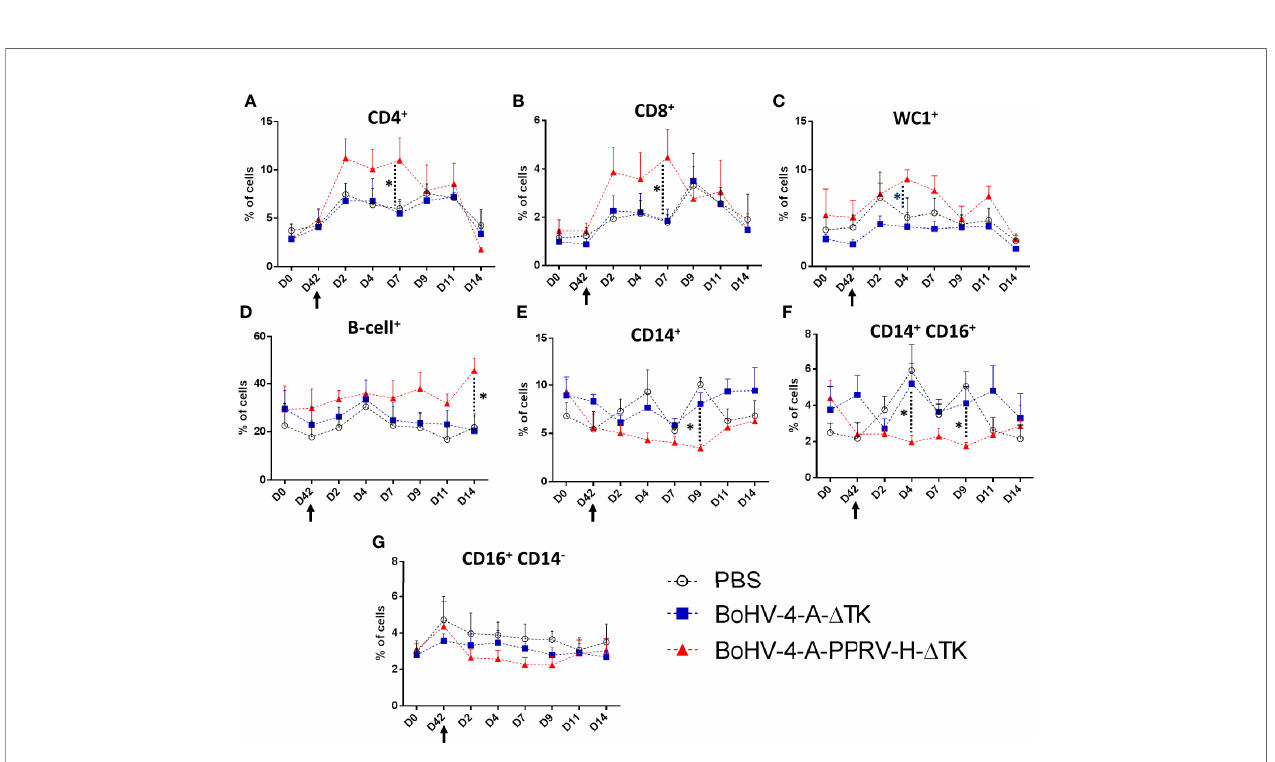
FIGURE 8 | Effect of BoHV-4-A-PPRV-H- D TK vaccination in ovine PBMC populations. PBMCs obtained from the three treatment groups [PBS (black), BoHV-4-A- D TK (blue), and BoHV-4-A-PPRV-H- D TK (red)] were stained with different monoclonal antibodies and analyzed by fl ow cytometry at different time points [pre- immunization (D0), pre-challenge (D42), and days 2, 4, 7, 9, 11, and 14 post-challenge (PC)]. Average percentage of (A) CD4 + cell population, (B) CD8 + cell population, (C) WC1 + ( gd T cell) population, (D) B-cell + population, (E) CD14 + cell population, (F) CD14 + CD16 + cell population, and (G) CD16 + CD14 − cell population for each sheep group were plotted. * p < 0.05 one-way ANOVA test (BoHV-4-A-PPRV-H- D TK vs . BoHV-4-A- D TK and PBS control groups). The black arrow (D42) denotes the time of virulent PPRV ICV ’ 89 challenge in all